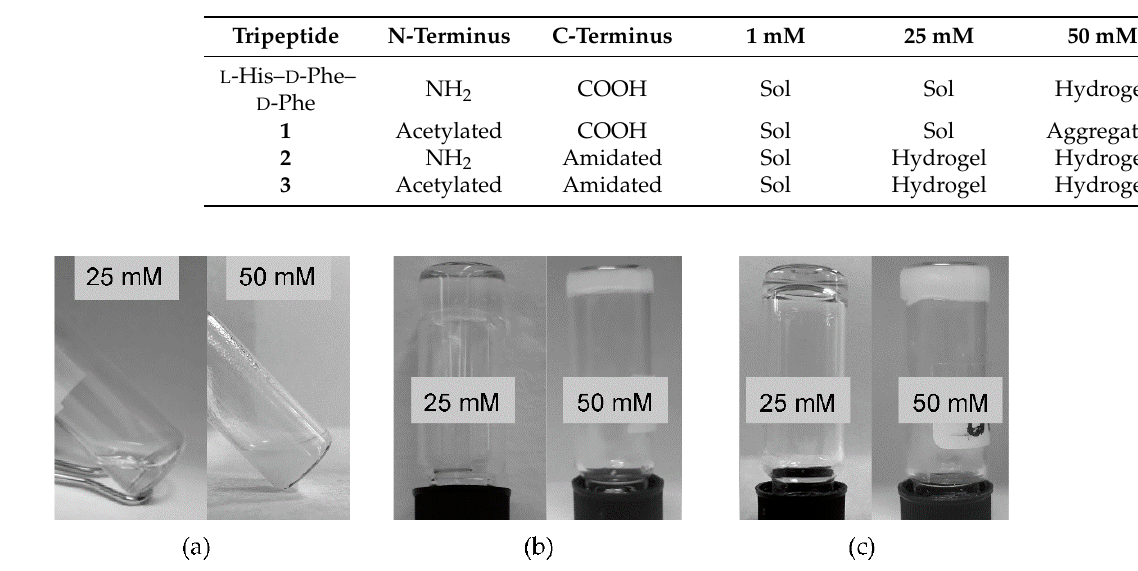
Figure 1. Photographs of ( a ) 1 , ( b ) 2 , and ( c ) 3 in phosphate buffer at 25 and 50 mM.